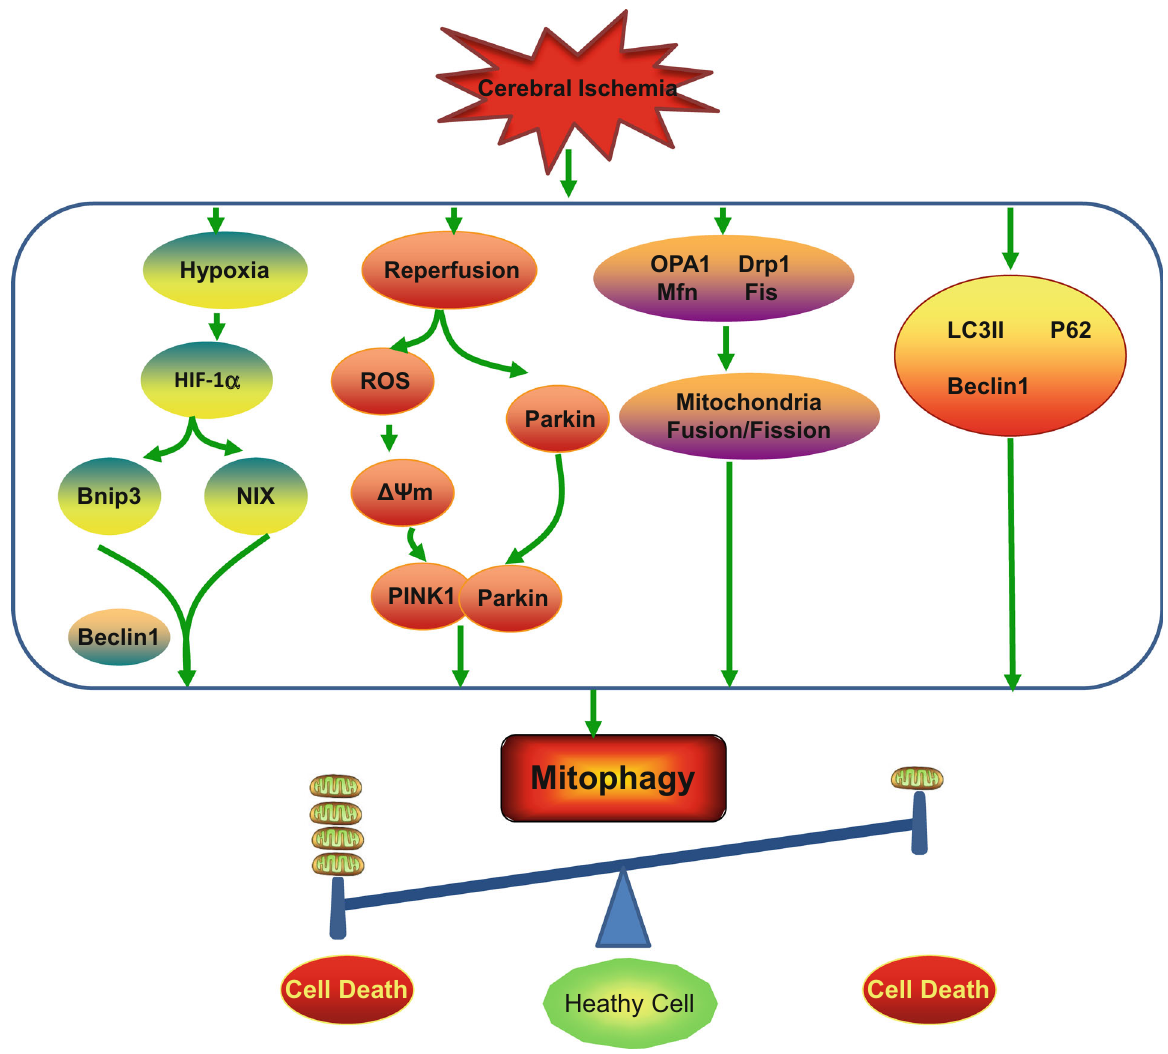
Figure 3. Possible mitophagy signalling pathways involved in cerebral ischemia. During the process of cerebral ischemia, many different signalling pathways are involved in the activation or suppression of mitophagy. (1) The process of cerebral ischemia can cause hypoxic conditions in tissue, which can increase the Bnip3 and NIX levels, and cause release of Beclin1 from the